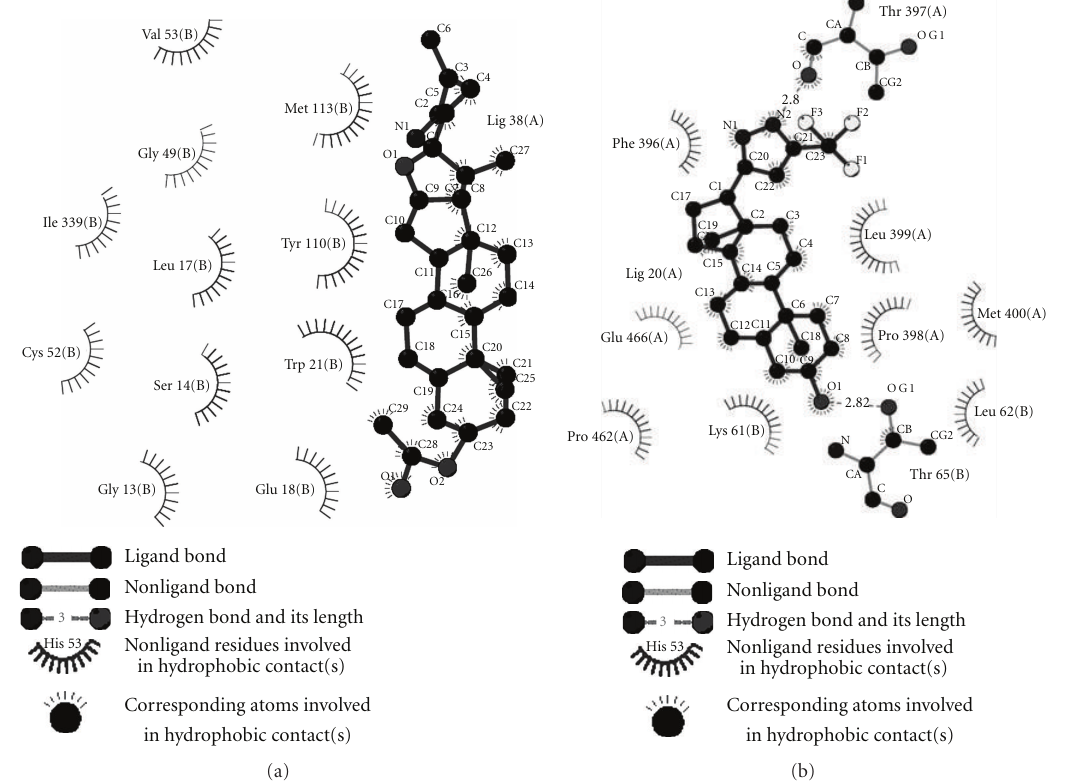
Figure 4: Ligplot showing proposed hydrogen bonding and non bonding interaction of Compound 38 (a) and Compound 20 (b) from Cluster 1, Cluster 2, respectively. They bind to the active site with specific interaction pattern representation of each cluster. Compound 38 stacks itself between two hydrophobic patches in the active site, whereas compound 20 is in nonbonding interaction with Z site residues and Glu of active